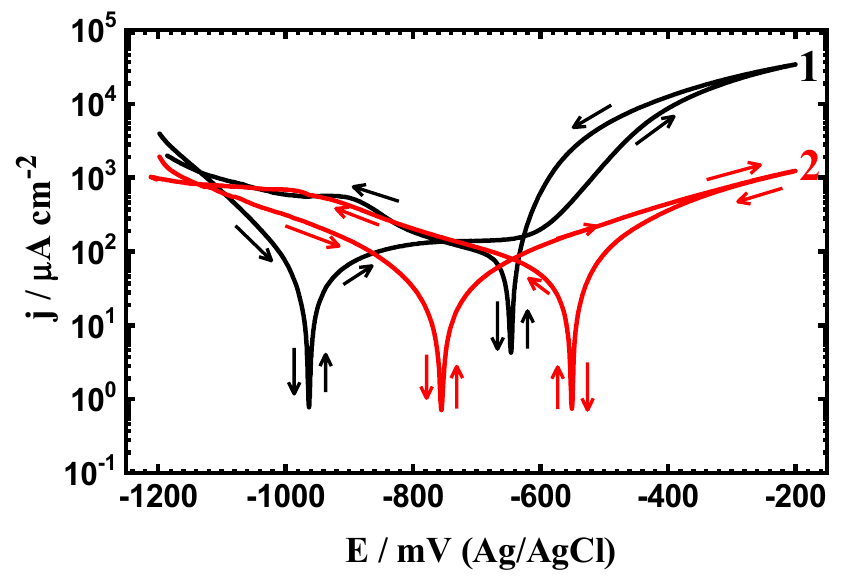
Figure 2. PCP curves of ( 1 ) API-2H steel and ( 2 ) 75% Cr 3 C 2 − 25%NiCr coated API-2H steel after exposure in 4% NaCl solution for 24 h.